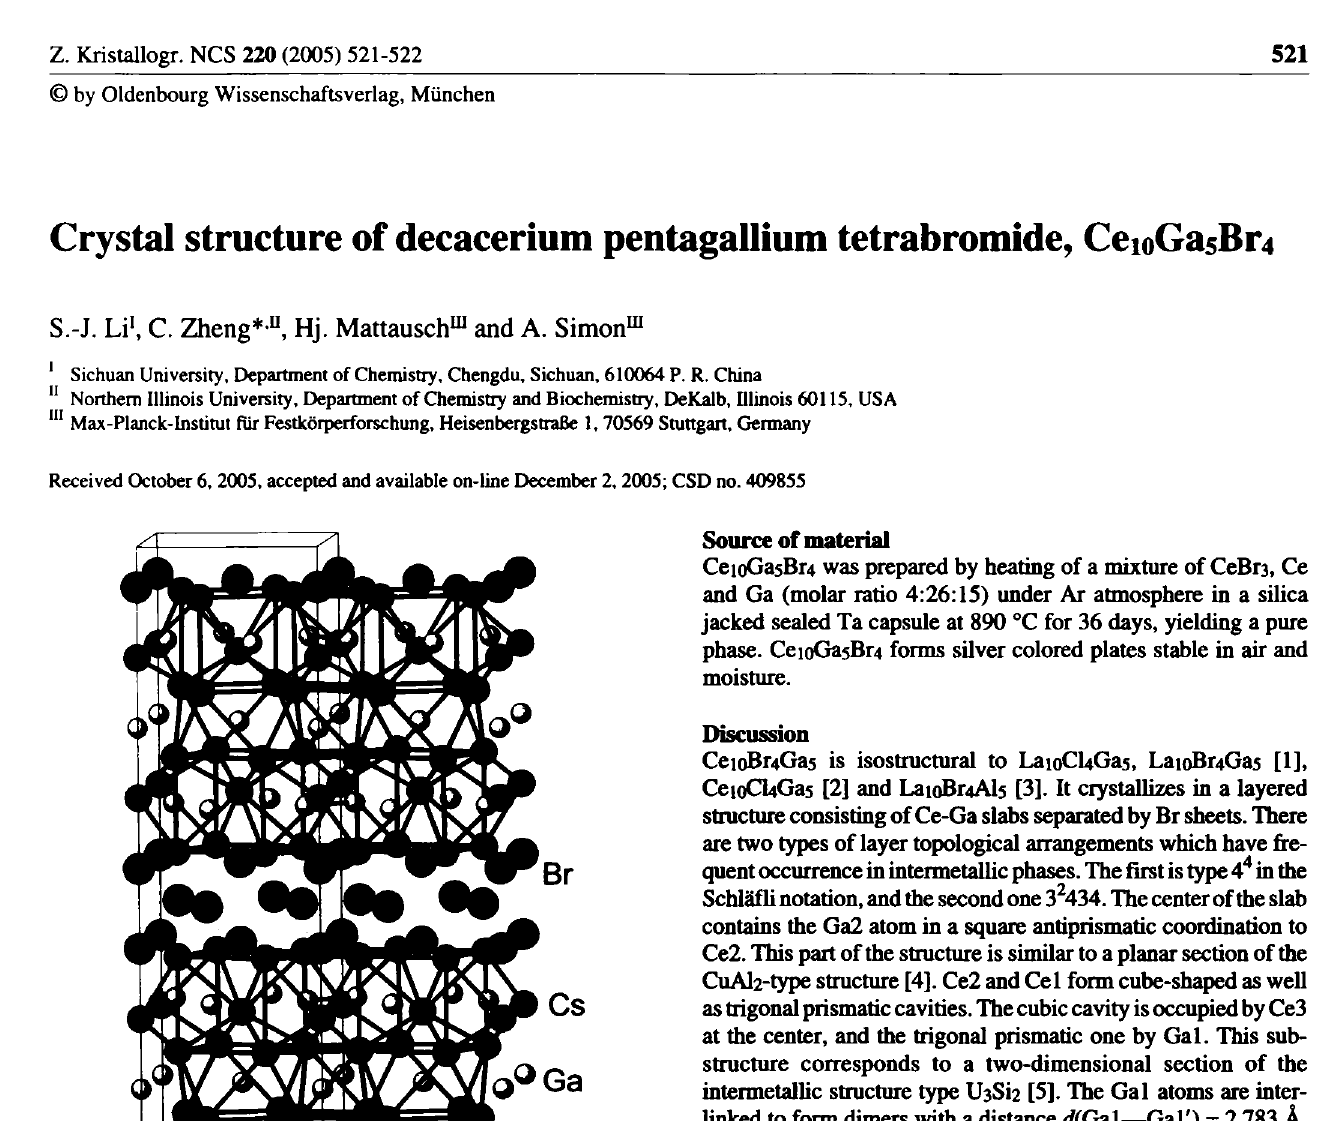
Table 1. Data collection and handling.